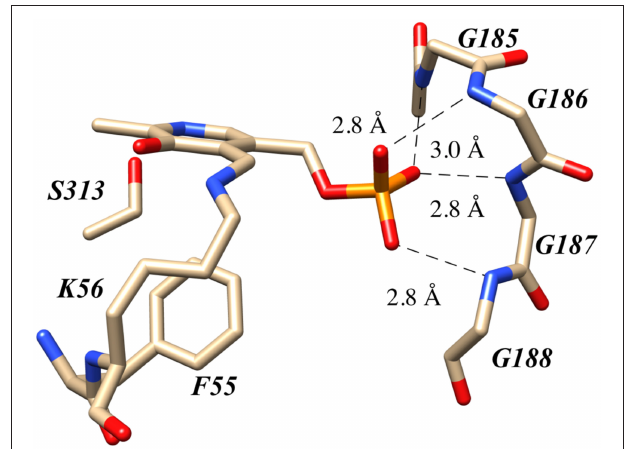
FIGURE 5 | The canonical tetraglycine loop that serves as a PLP phosphate binding pocket as seen in the hSR structure PDB